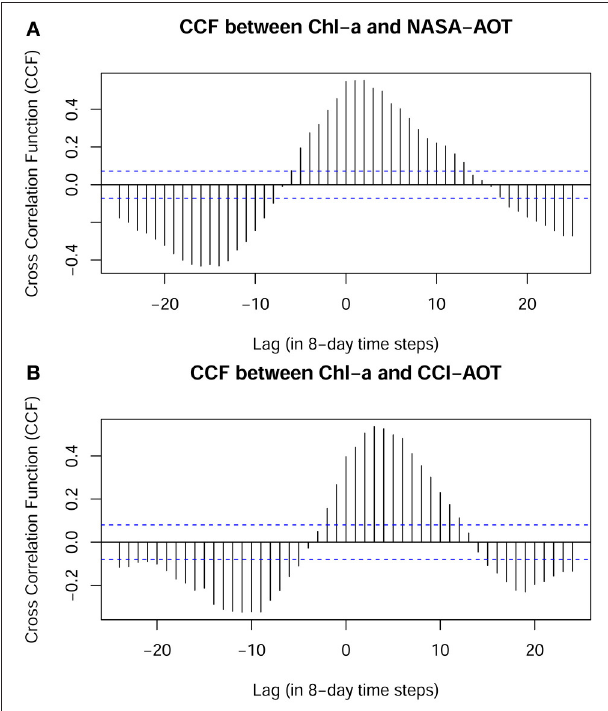
FIGURE 4 | Cross Correlation Function between (A) Chl-a and NASA-AOT (B) Chl-a and CCI-AOT for study area off Somalia.Time step is 8 days.